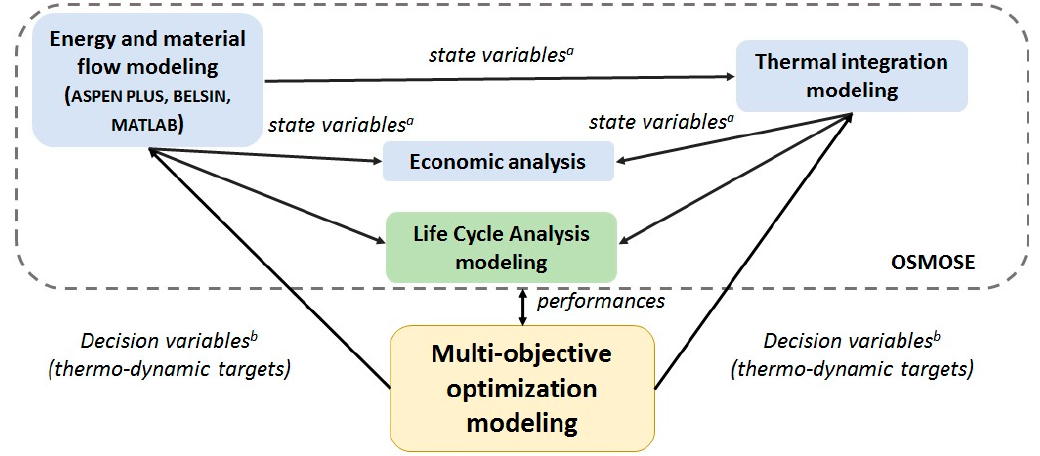
Figure B1. Modeling methodology possible in the OSMOSE (OptimiSation Multi-Objectifs de Systemes Energetiques integres) platform.